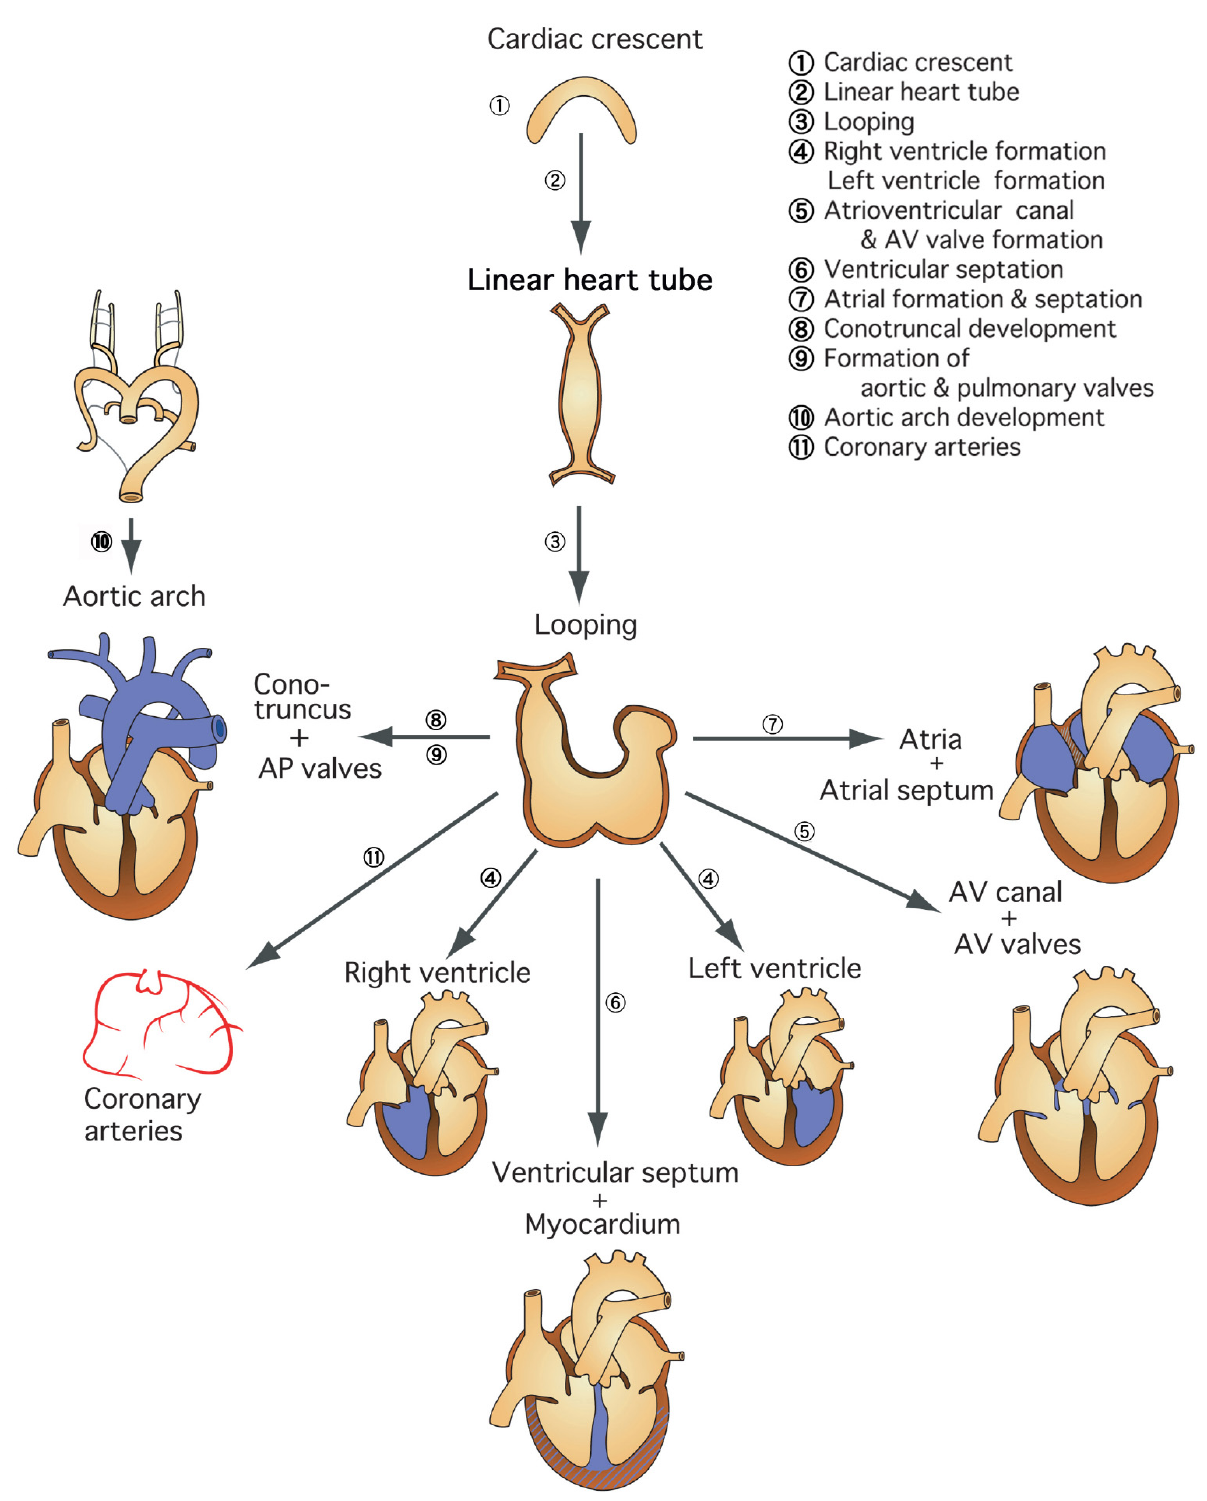
Figure 1. Molecular embryology for an understanding of the individual modular steps in cardiovascular development. To better understand this complex process, it may be helpful to divide it into several regions or steps. Because most congenital heart diseases that we encounter in our daily practice are specific developmental abnormalities in one of these regions, this concept is also important for understanding the etiology of congenital heart